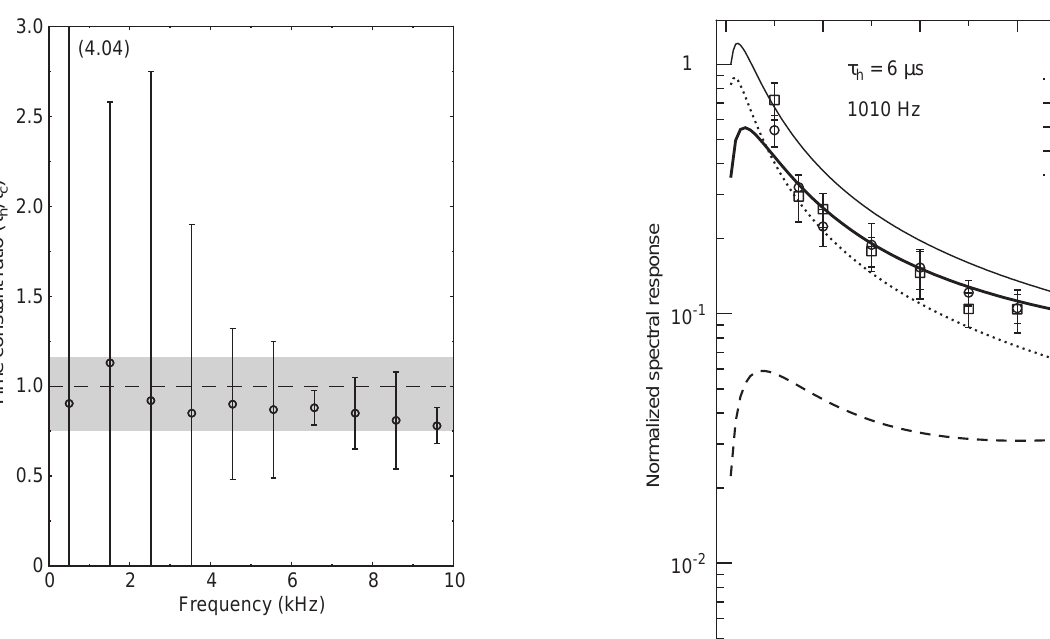
Fig. 10. Ratio of heating to cooling time constants of the modulated current in the ionosphere, derived for odd harmonics as a function of the harmonic frequency